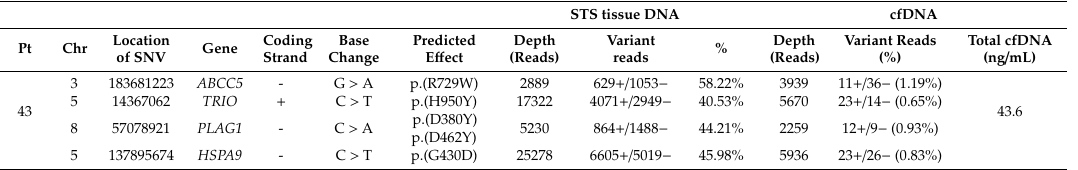
Table 4. Tumour and plasma variants identified in STS patient analysed using targeted NGS (‘Sarcoma V345 (cid:48)